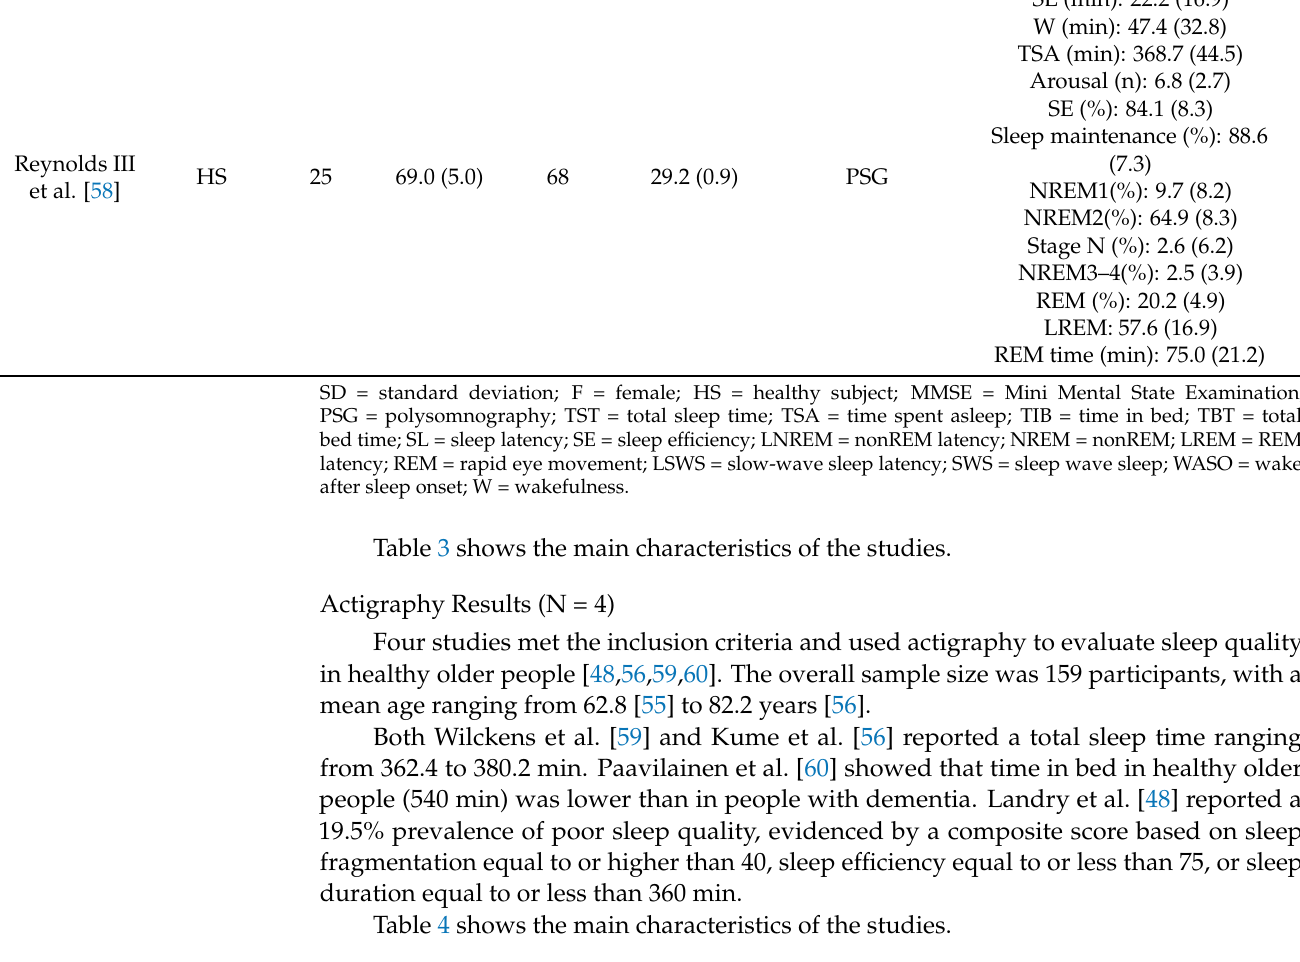
Table 4. Sleep in older age. Summary of all the studies that use